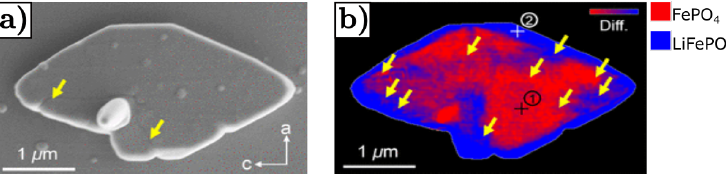
Figure 18. Relation between defects and phase distribution within micrometric LFP chemically delithiated plate-like crystal, with ( a ) SEM image and ( b ) Chemical phase distribution map. Reprinted with permission by American Chemical Society from [97], Copyright